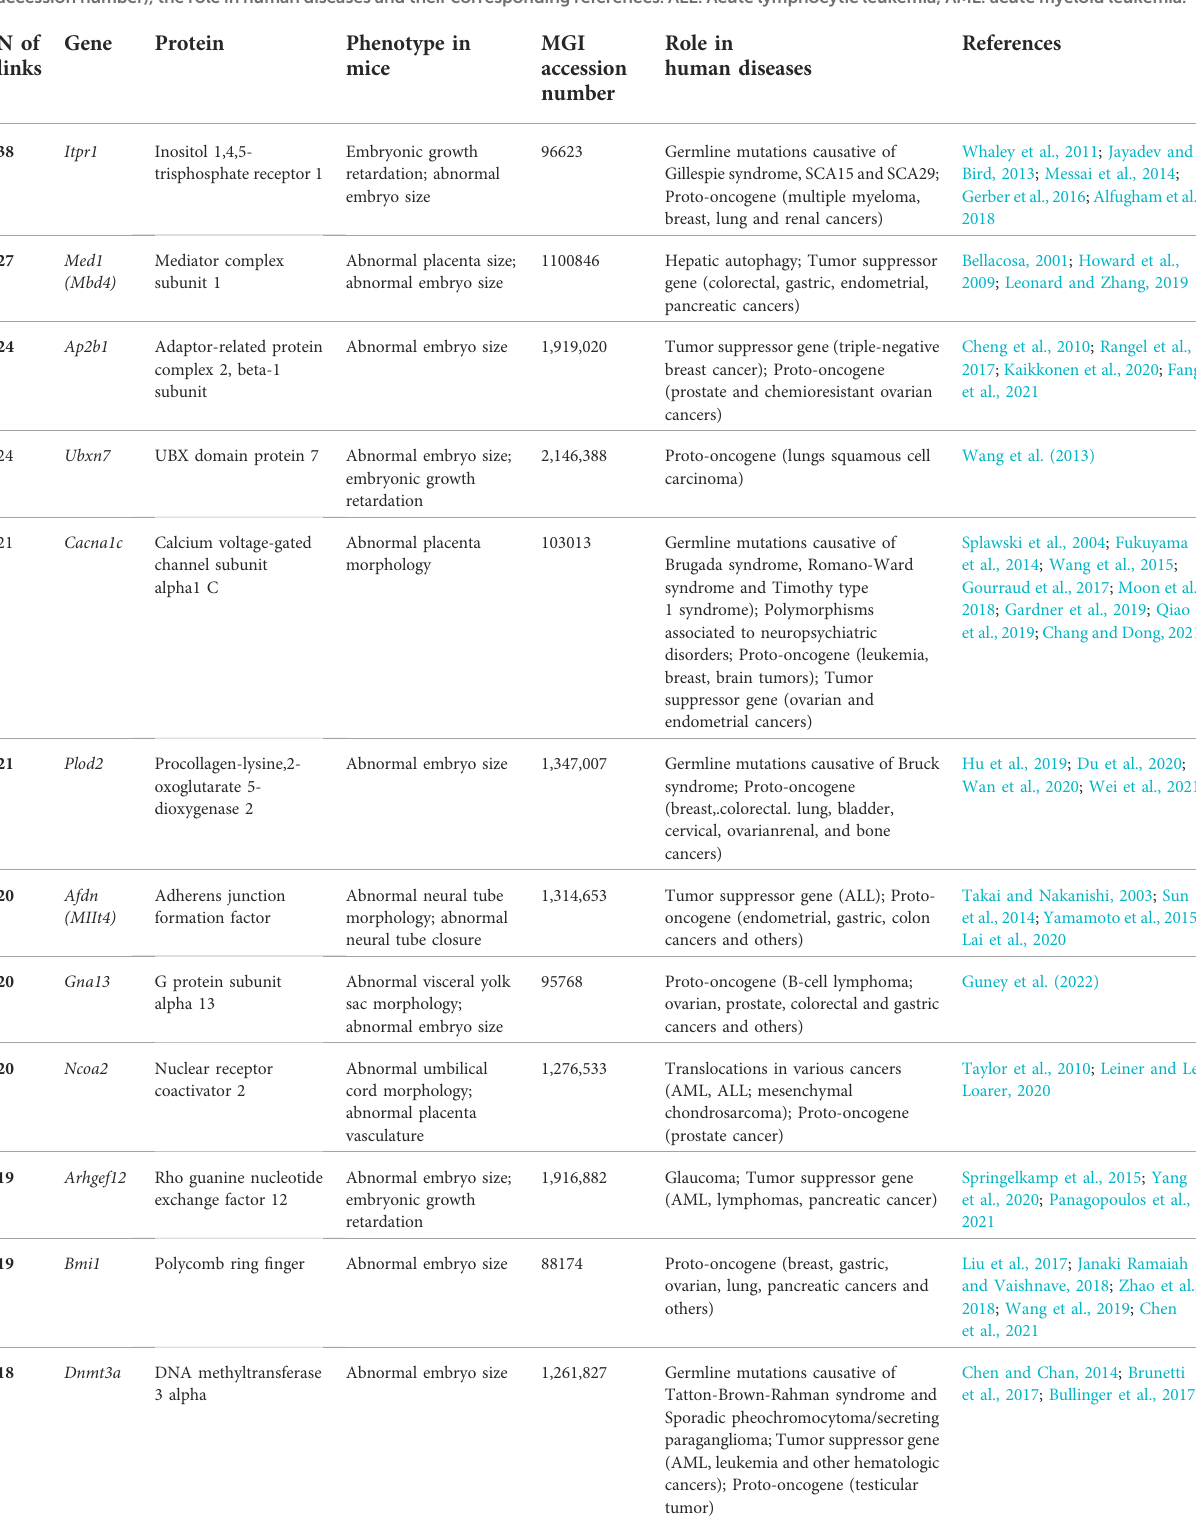
TABLE 5 Genes studied in mice KO models in terms of their relationship with the embryo phenotype. The table shows the number of links for each gene, the genes and the protein for which codi fi es, the phenotype in mice with the corresponding MGI (mouse genome informatic database accession number), the role in human diseases and their corresponding references. ALL: Acute lymphocytic leukemia; AML: acute myeloid